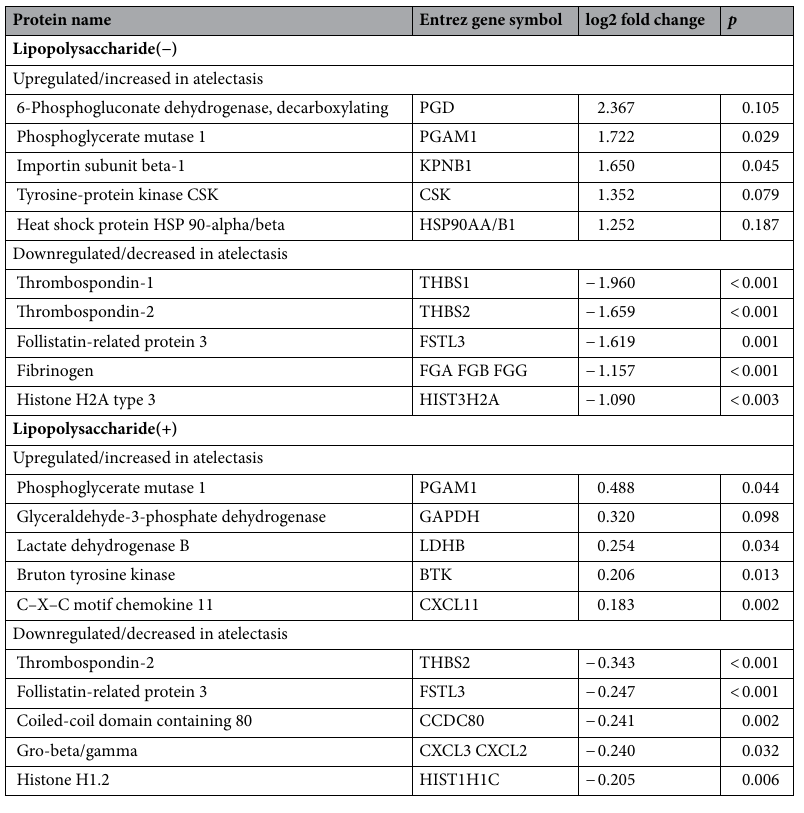
Table 1. Proteins with largest and smallest fold changes in atelectatic